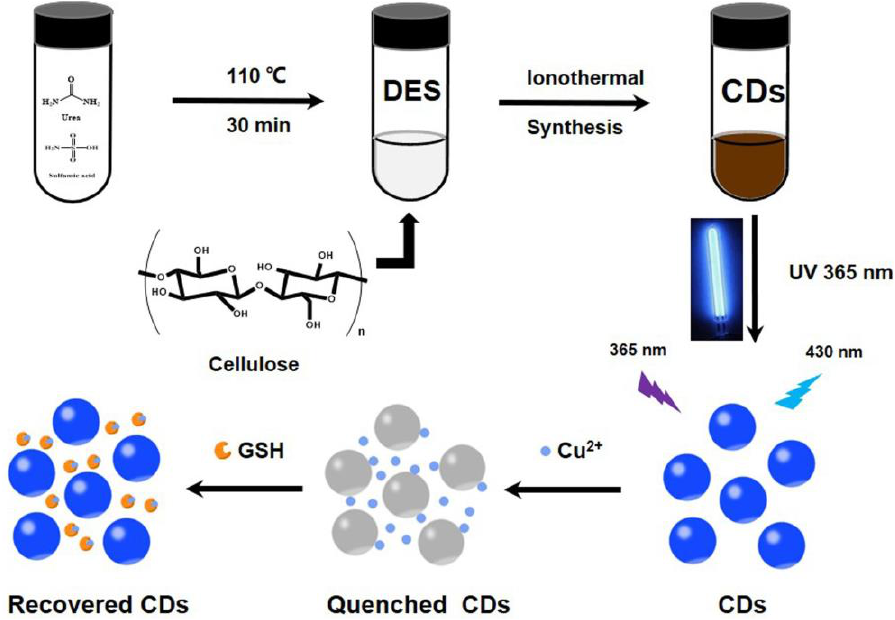
Figure 8. Schematic preparation of N- and S-CDs and their detection for Cu 2+ and GSH (reproduced with the permission from Ref. [113]).